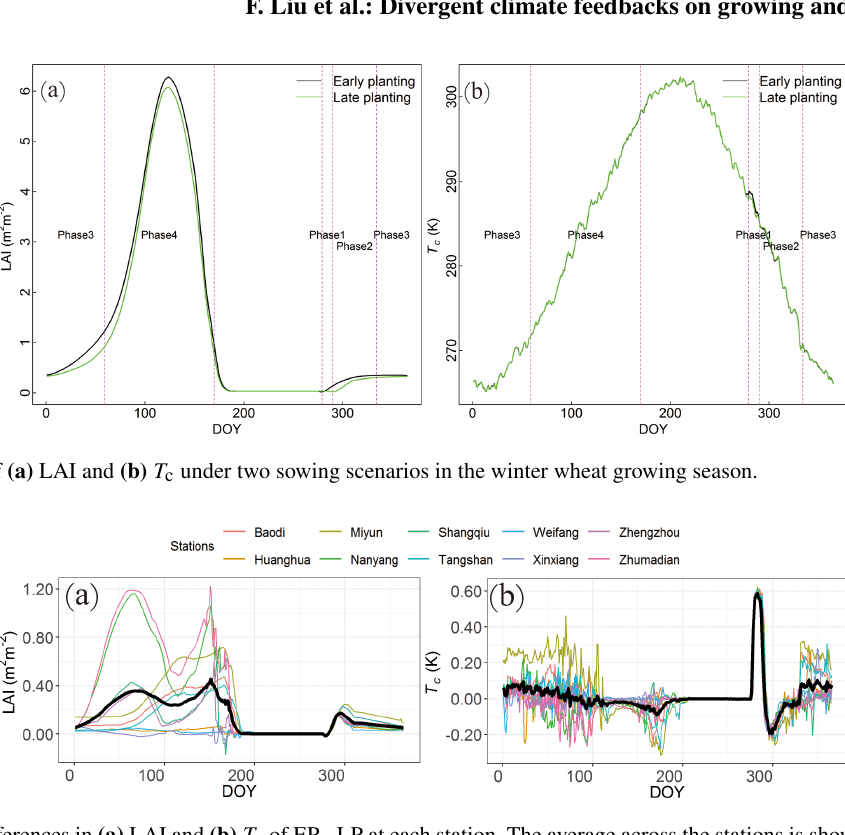
Figure 3. Seasonal differences in (a) LAI and (b) T c of EP − LP at each station. The average across the stations is shown as a bold black line.